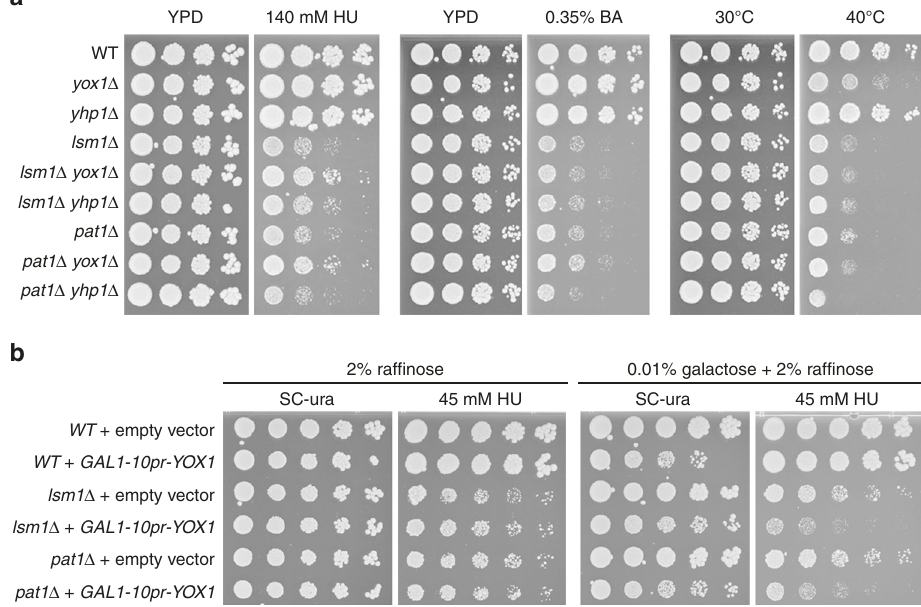
Fig. 3 YOX1 toxicity is speci fi c to DNA replication stress. a Serial 10-fold dilutions of the indicated strains were spotted on YPD with or without HU, boric acid (BA) or at high temperature (40 °C). Plates were imaged after 2 – 3 days of growth to assess the sensitivity of each strain to each treatment. b Serial 5-fold dilutions of WT (BY4741), lsm1 Δ or pat1 Δ cells containing pBY011 (empty vector) or pBY011- YOX1 ( GAL1-10pr-YOX1 ) plasmids were spotted on synthetic complete medium lacking uracil and containing raf fi nose or raf fi nose and galactose, with or without HU. Plates were imaged after 7 days of growth to assess the effect of YOX1 expression on HU